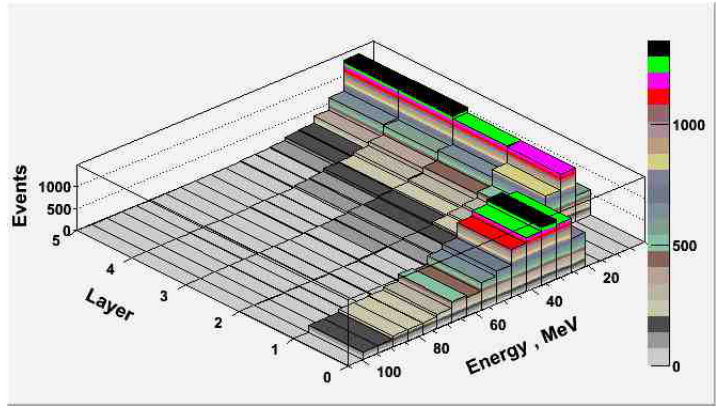
Figure 6. Energy distribution of the number of signals for charged particles in each layer